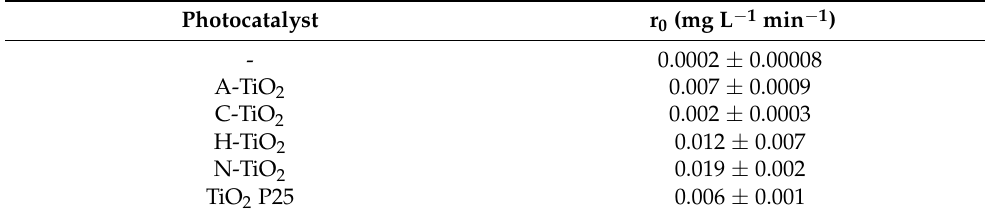
Table 2. Initial degradation (r 0 ) rates during photocatalytic oxidation of 5 mg L − 1 MG in the presence of 0.5 g L − 1 photocatalyst and visible light